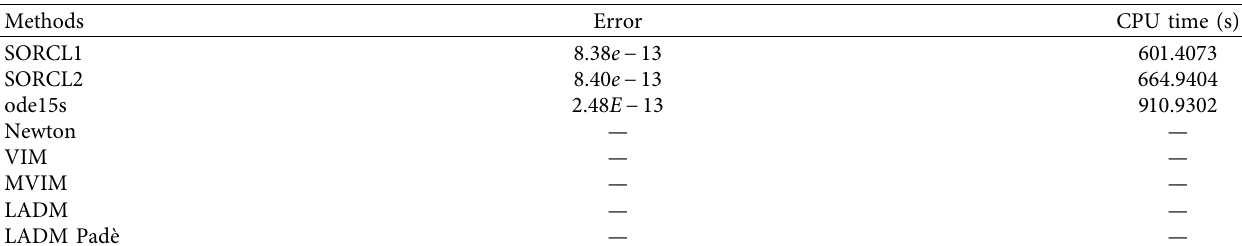
Figure 2: (a) Approximate values of T , I , and V cells using SORCL1 method. (b) Approximate results for T , I , and V cells using SORCL2 method. Table 4: Numerical comparison diferent methods, with ω � 1 . 9 and θ � 1/2 for SORCL1 and SORCL2 to solve Problem